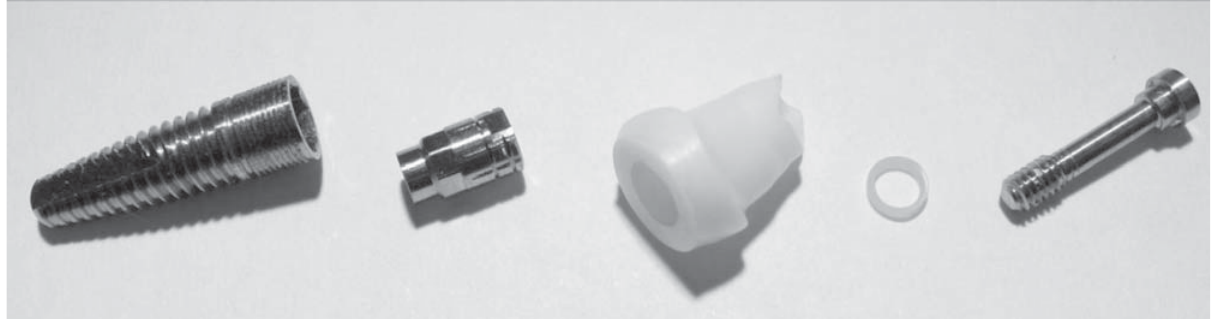
Figure 2- Components of the custom-made abutment composed by an individualized zirconia abutment cemented on a titanium connection linked to the implant using a titanium screw. A peek ring was used for stress distribution at the zirconia/ titanium interface interposed between the zirconia abutment and retaining screw